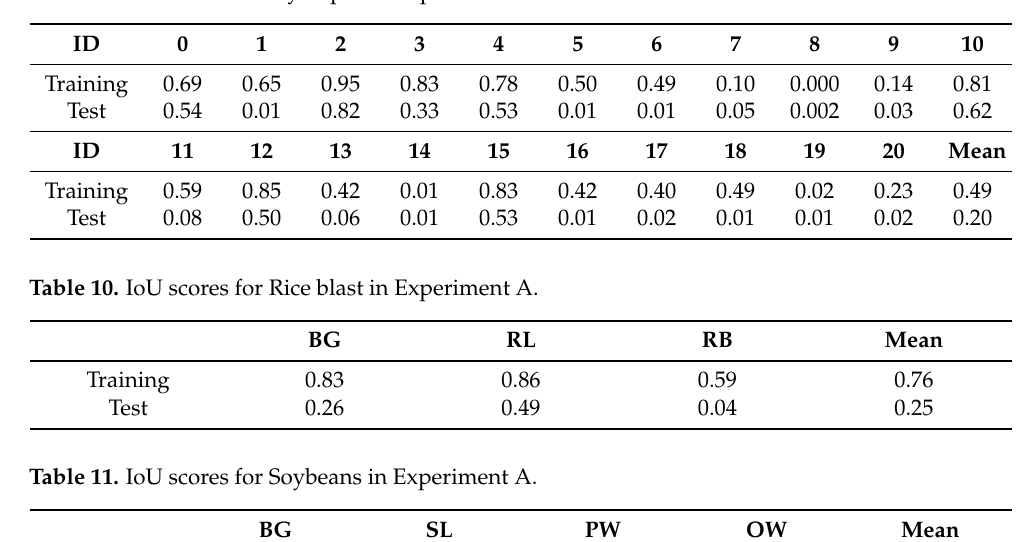
Table 9. IoU scores for Cityscapes in Experiment A.